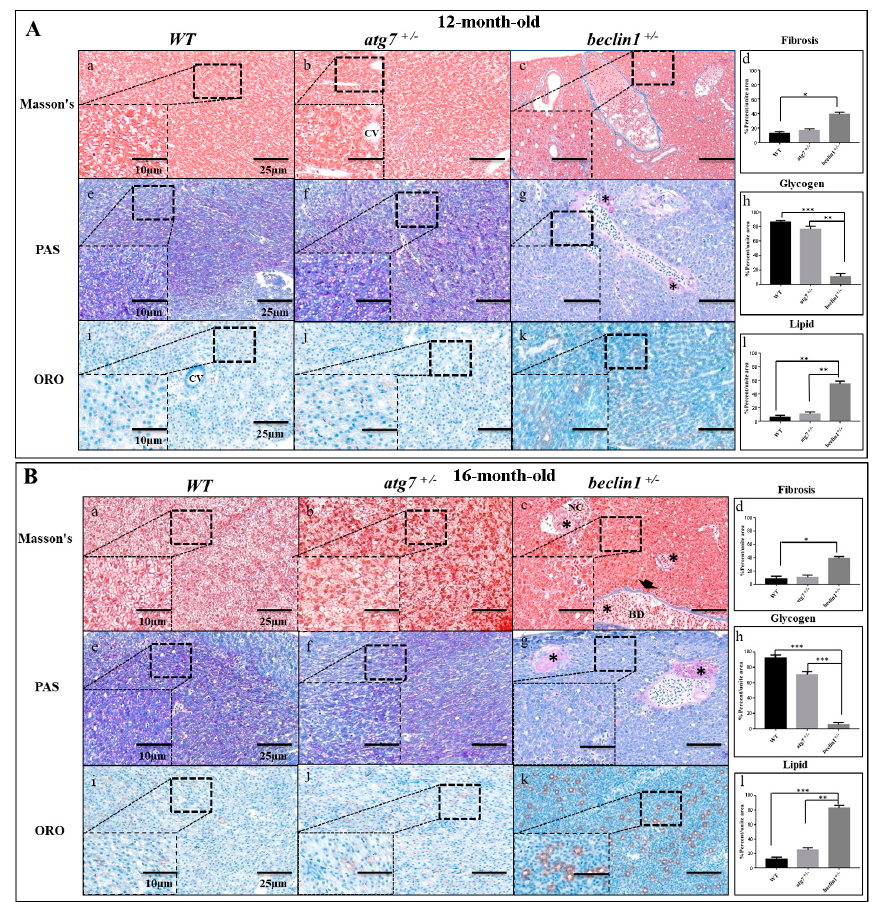
Figure 3. Defects of hepatic energy metabolism in male Beclin1 +/ − zebrafish. ( A ) Histological assessment of hepatocytes in 12-month-old male zebrafish. ( a – d ) Representative photomicrographs of Masson’s trichrome staining and the quantification of fibrosis. ( e – h ) Representative photomicrographs of Periodic Acid-Schiff (PAS) staining and glycogen content showing that glycogen packed in the hepatocytes of wild type (WT) and atg7 +/ − and lacked in beclin1 +/ − zebrafish; notice the beginning of hepatocellular malignancy (black star) around bile ducts. ( i – l ) Oil Red O (ORO) staining and lipid quantification revealing the alternations in fat droplet formation in beclin1 +/ − hepatocytes. ( B ) Histological assessment of hepatocytes in 16-month-old male zebrafish. ( a – d ) Representative photomicrographs Masson’s trichrome staining and fibrosis quantification with few fibrils lining the bile duct (arrowhead) and tumor-like cells (black stars) in beclin1 +/ − . ( e – h ) Representative photomicrographs of PAS staining with sufficient glycogen in WT and atg7 +/ − and sever glycogen reduction in beclin1 +/ − , notice the necrotic development around bile ducts (black stars). ( i – l ) ORO stain and lipid quantification showing hepatocytes hypertrophy with lipid accumulation and fatty clouds in beclin1 +/ − zebrafish. Scale magnification is shown in pictures and data are expressed as mean ± SD. * p < 0.05, ** p < 0.01, and *** p < 0.001. CV: Central Vein; BD: Bile Duct; NC: Necrosis.